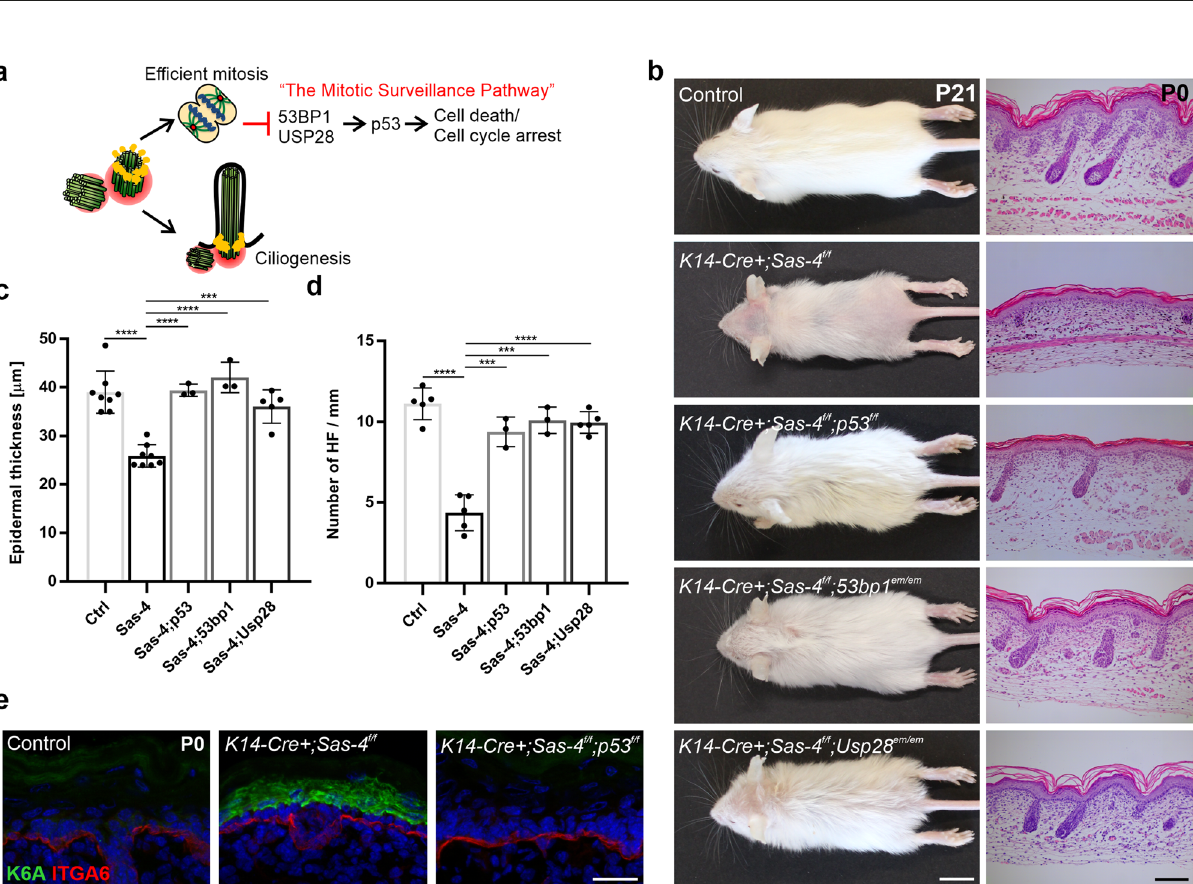
Fig. 2 Upregulation of p53 in the centrosome mutant epidermis. a Immunostaining of Control and K14-Cre + ; Sas-4 f/f back-skin sections at the indicated stages showing the loss of the centrosome marker (TUBG, green) and gradually increase in nuclear p53 (red) in the mutant mice (scale bar: 20 µ m). The dashed line represents the epidermal-dermal interface in all panels. b Quanti fi cation of the percentage of p53-positive nuclei in the back-skin basal epidermis of control and K14-Cre + ; Sas-4 f/f mice at the corresponding stage shown in ( a ). n = 3 for controls and K14-Cre + ; Sas-4 f/f from E12.5 – E14.5 and n = 5 for Controls and K14-Cre + ; Sas-4 f/f at E15.5 and P0. Bars represent mean ± SD in these and subsequent graphs. ns not signi fi cant, **** p < 0.0001 (two-tailed student ’ s T -test). c , d Immunostaining ( c ) and quanti fi cation ( d ) of Control ( n = 5) and K14-Cre + ; Sas-4 f/f ( n = 5) back-skin sections at E15.5 for cell death (Cl.CASP3, red) in the mutant epidermis (scale bar: 20 µ m). e Similar to ( d ) but at P0 with n = 5 for each genotype. d , e * p < 0.05, ** p < 0.01 (two-tailed student ’ s T -test). f Cell cycle pro fi les of isolated primary keratinocytes at P0 of Control ( n = 3) and K14-Cre + ; Sas-4 f/f ( n = 3) mice. ns not signi fi cant (two-tailed student ’ s T -test). g Quanti fi cation of the percentage of pHH3-positive cells in the basal layer of back-skin epidermal sections at E15.5 of Control ( n = 5), K14-Cre + ; Sas-4 f/f ( n = 5), K14-Cre + ; Sas-4 f/w ; p53 f/f ( n = 5) and K14-Cre + ; Sas-4 f/f ; p53 f/f ( n = 4) mice. ns not signi fi cant, * p < 0.05 (two-tailed student ’ s T -test). h Bar chart depicting the over-represented pathways (from the pathway interaction database (PID)) of differentially expressed genes in the K14-Cre + ; Sas-4 f/f epidermis compared to controls at E13.5. The X -axis represents the negative log 10 of the q -values, the adjusted p- values optimized by the false discovery rate. i Similar to ( h ) but for P0 epidermal kerat i nocytes. j Venn diagram showing the overlap of published p63